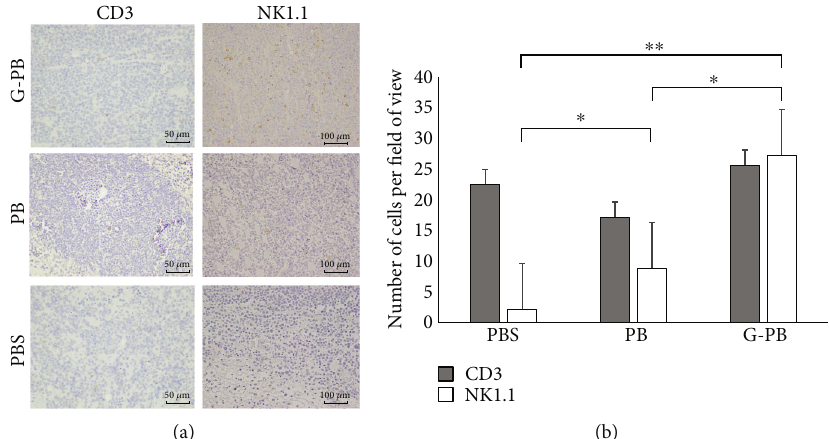
Figure 5: Evaluation of NK cell neutrophil-induced antitumor e ff ect enhancement by immunopathology. PBS, PB, and G-PB were intraperitoneally injected on day 21 after BMT and subcutaneous injection of A20, and the tumor was removed 2 days later. The removed tumor was immunostained with CD3 and NK1.1 to evaluate the transfer of T cells and NK cells to the tumor (a). The number of NK1.1- and CD3-positive cells per fi eld of view was counted for three locations in the tumor (b). ∗ p < 0 : 01 and ∗∗ p < 0 : 001